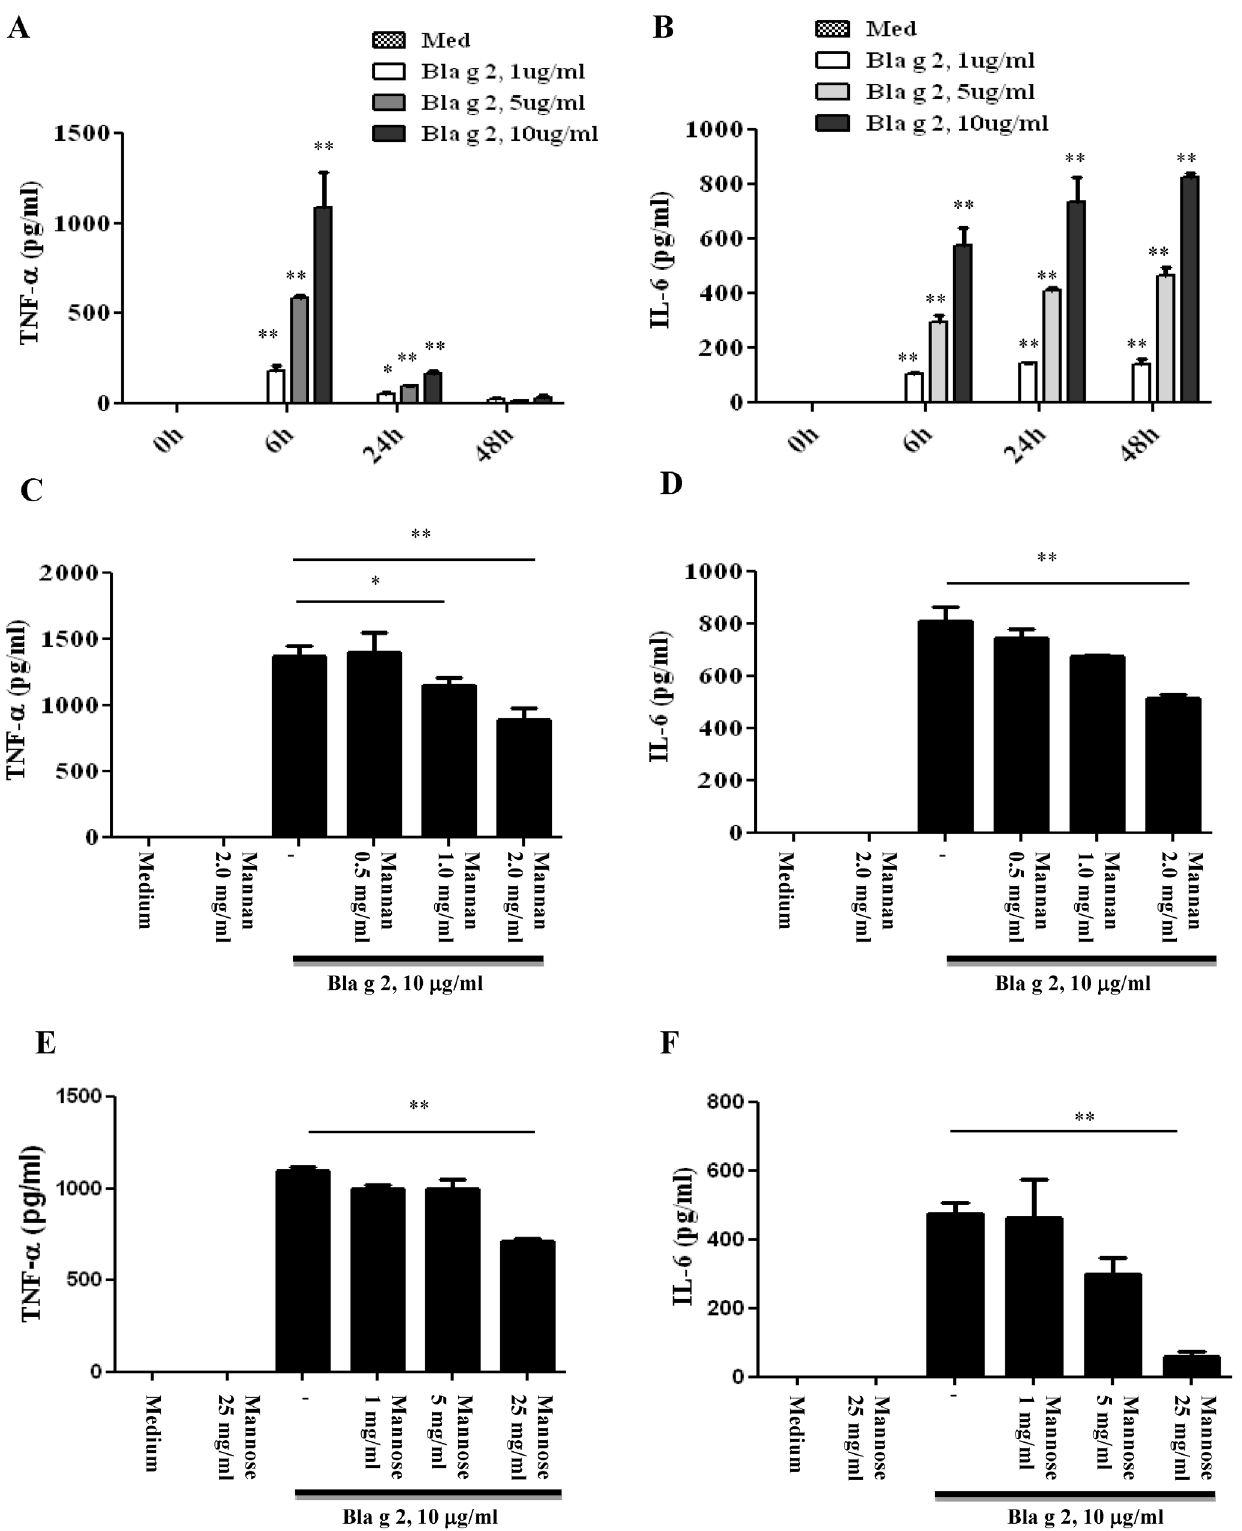
Figure 5. Bla g 2 induced TNF- a and IL6 secretion by fibrocytes was partially through CD206. ( A–B ) Different doses of Bla g 2 induced cytokine production at different times in supernatants of cultured fibrocytes including TNF- a ( A ) and IL6 ( B ) were detected using ELISA kits. ( C–F ) Fibrocytes were pretreated with either mannan (3 mg/ml) or mannose (25mg/ml) before Bla g 2 treatment (10 m g/ml), levels of fibrocyte secreted TNF- a ( C, E ) and IL6 ( D, F ) were detected. Data are mean 6 SD of three individual experiments. * P , 0.05, ** P , 0.01.